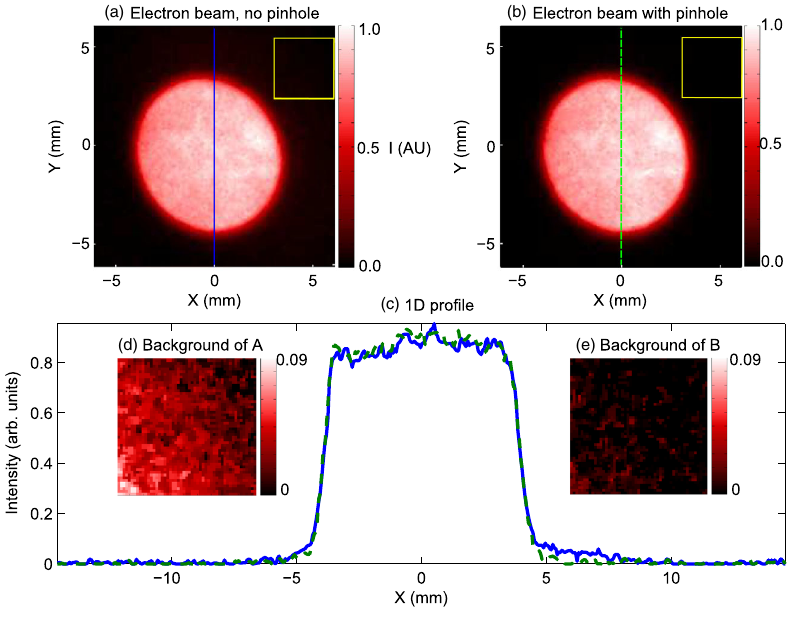
FIG. 5. (a) Resultant beam profile when the flattop shown in Fig. 3(c) is transported to the cathode and the beam imaged on the viewscreen. (b) Beam result when a pinhole is placed in the image plane of the second lens downstream of the SLM. (c) 1D profiles along the lines shown in (a) and (b). (d) Background of (a), taken from yellow boxed region. (e) Background of (b), taken from the yellow boxed